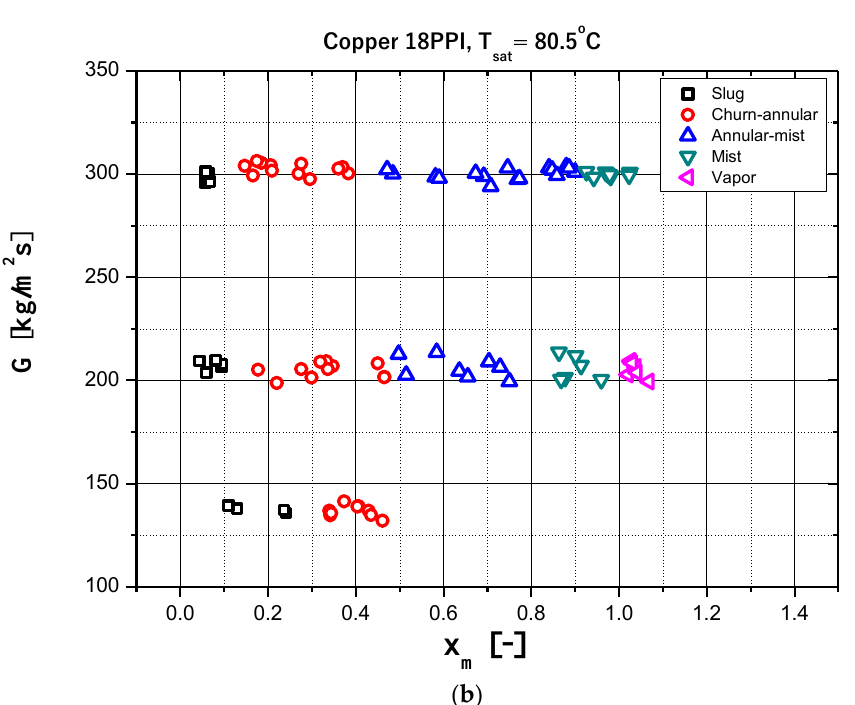
Figure 9. Flow pattern maps based on the vapor quality and mass flux in 18-PPI copper porous media filled channel ( a ) at T sat = 75.3 °C and ( b ) T sat = 80.5 °C.